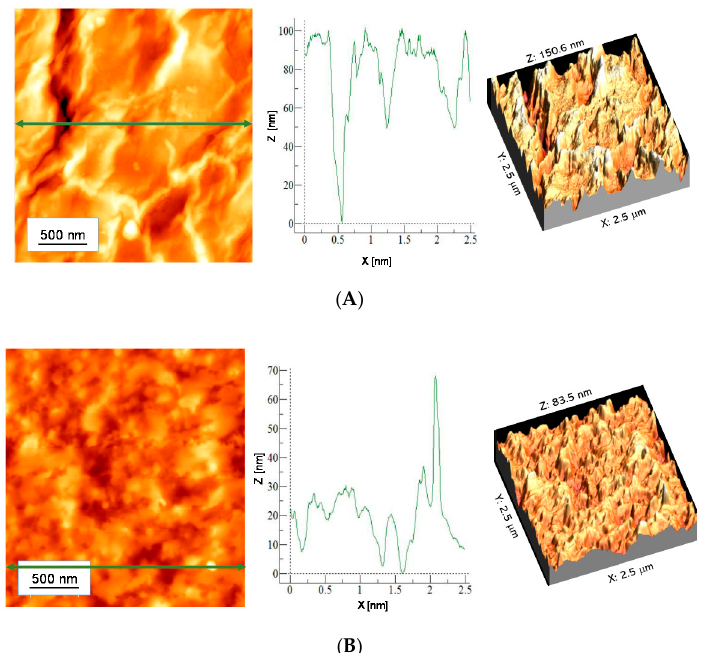
Figure 7. AFM images of unmodified hydrogels: ( A ) 10 mL PEGDA 700, ( B ) 12 mL PEGDA 700.